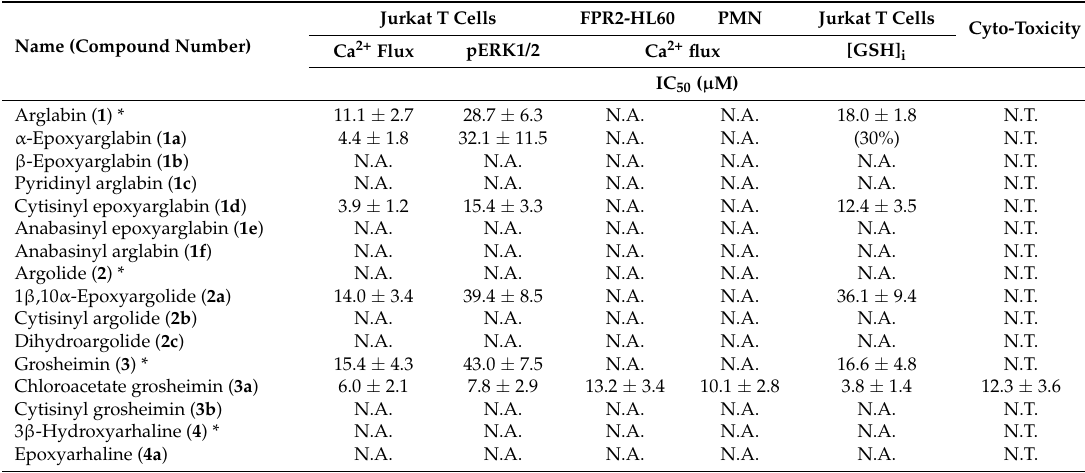
Table 1. Effect of SLs on Ca 2+ mobilization and ERK1/2 phosphorylation in Jurkat T